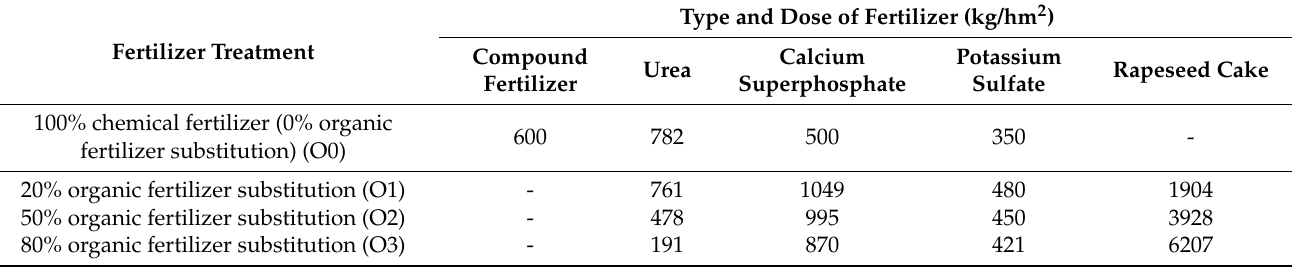
Table 1. Details of the application of fertilizer types and